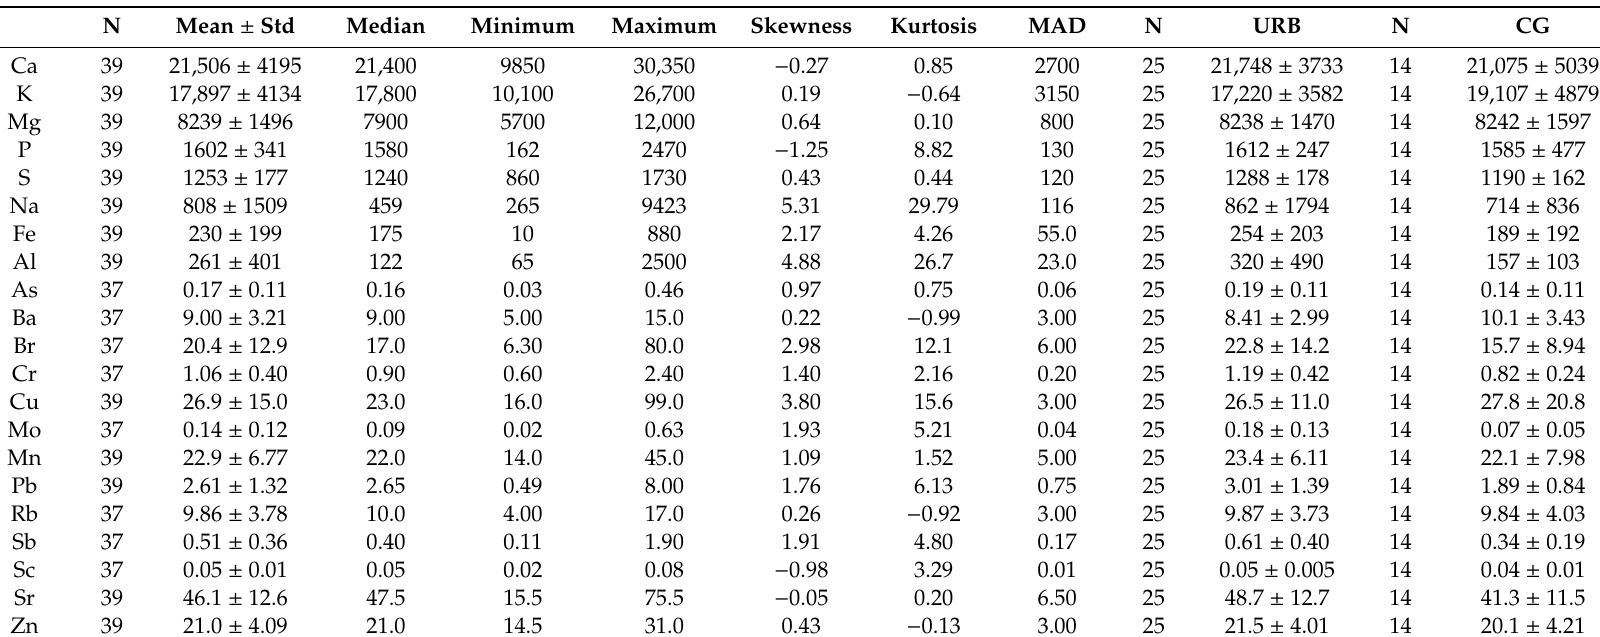
Table 2. Basic statistical parameters for a total of 39 Ficus macrophylla leaf samples. Data given in µ g g − 1 (dry biomass). Legend: N, number of analyzed samples; Std, standard deviation; MAD, median absolute